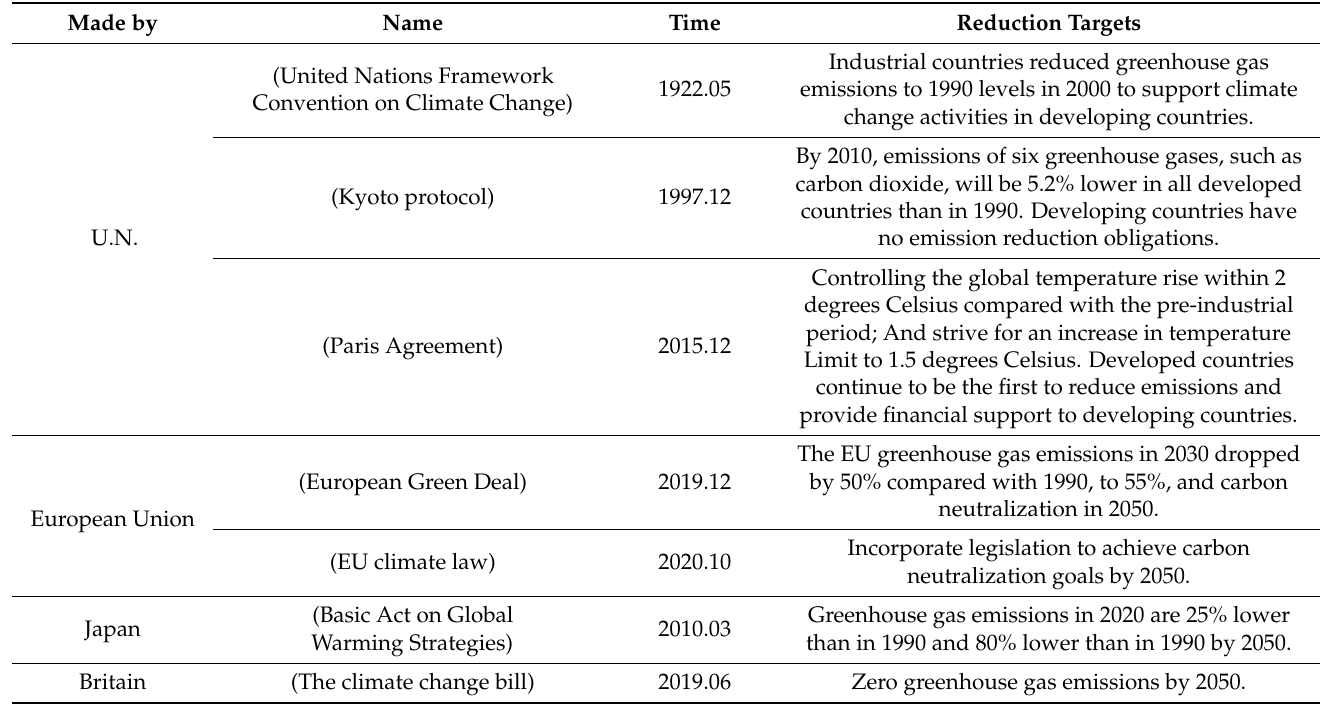
Table 1. List of legal documents concerning the UN and some other countries dealing with the climate